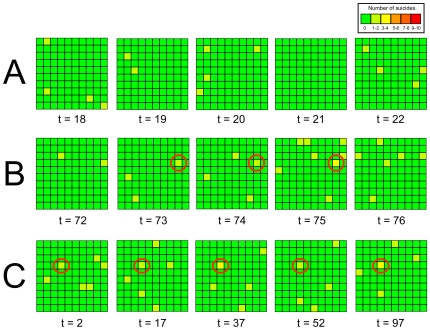
Three time series indicating (A) baseline suicide occurrences with no clustering, (B) a spatiotemporal cluster resulting from social learning, and (C) a spatial cluster resulting from homophily.Each square within the 10×10 grid indicates one 10-agent sub-group, with the colour of the square indicating the frequency of suicide from green (0%) to red (100%). In A, randomly distributed suicide events can be observed due to the non-copycat probability of suicide (p0 = 0.005). No clustering is detected under these conditions. In B, a spatiotemporal point cluster generated by social learning (s = 5) is marked with a red circle, and can be seen persisting over a period of three generations from t = 73 to t = 75 inclusive, thus showing localisation in both time and space. In C there is no social learning (s = 0), but homophily (h = 1) and large inter-group differences (q = 0.4) causes one sub-group, marked with a red circle, to be composed entirely of high suicide risk agents. This group repeatedly features suicides throughout the simulation run, forming a spatial (but not temporal) cluster despite the lack of social learning.